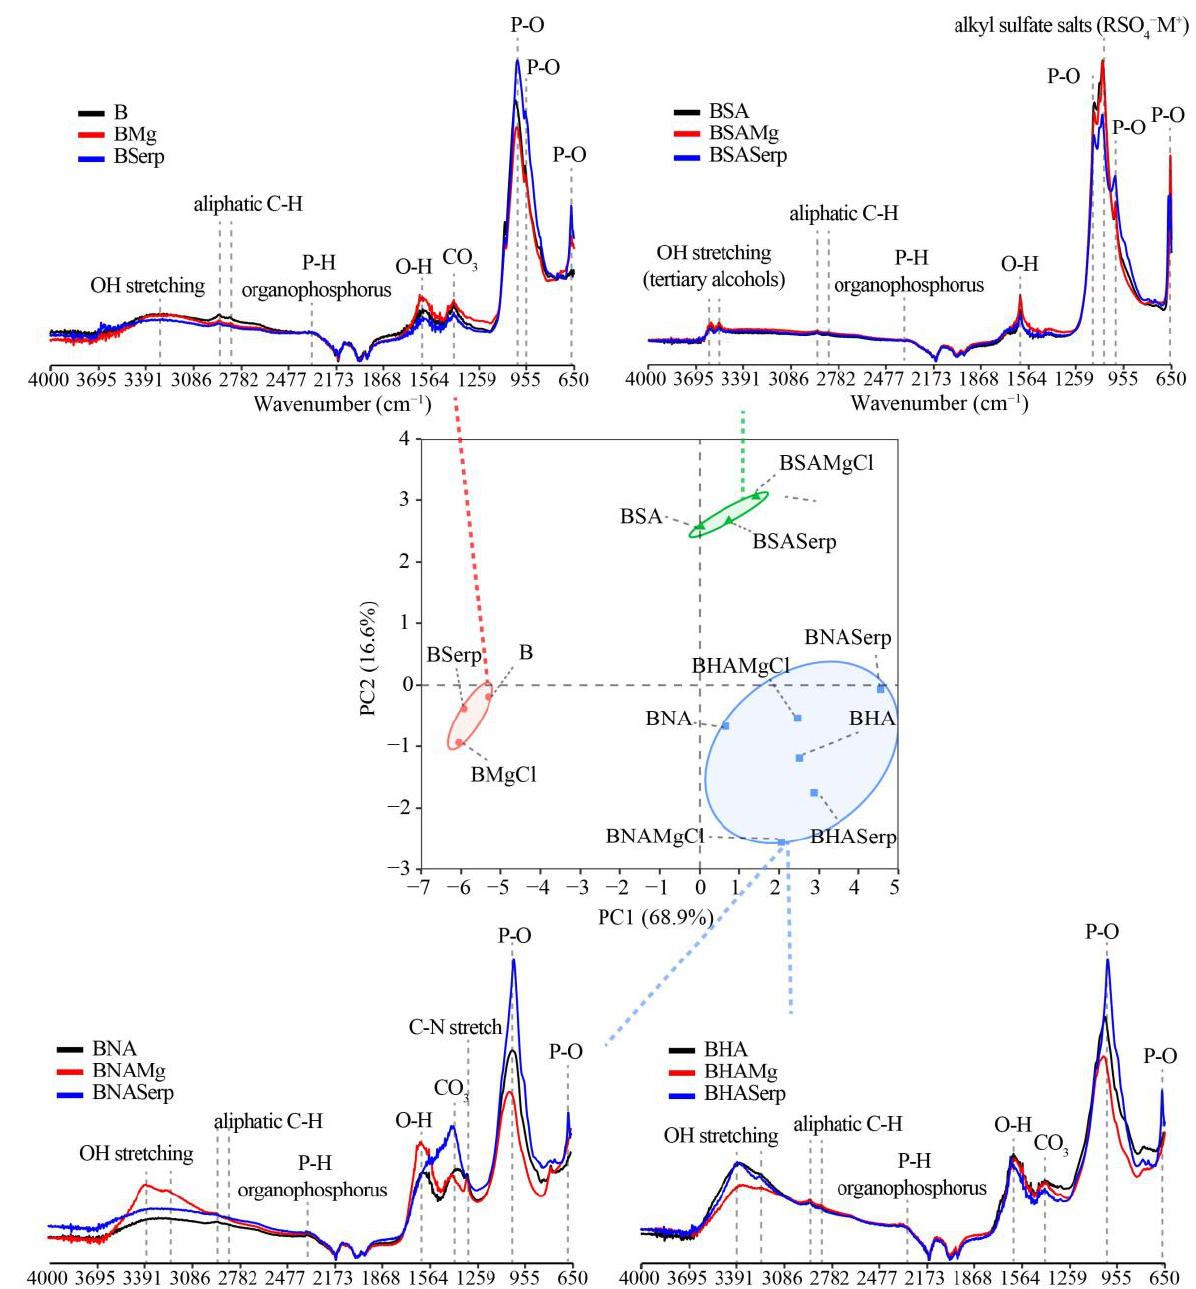
Figure 3. Attenuated total reflectance Fourier transform infrared spectrum of biochar based-fertilizers (BBFs) and their clustering (Based on the BBF spectral signature) in the principal component analysis (PCA) diagram. More details of the BBFs acronyms and synthesis routes are shown in Table 1.